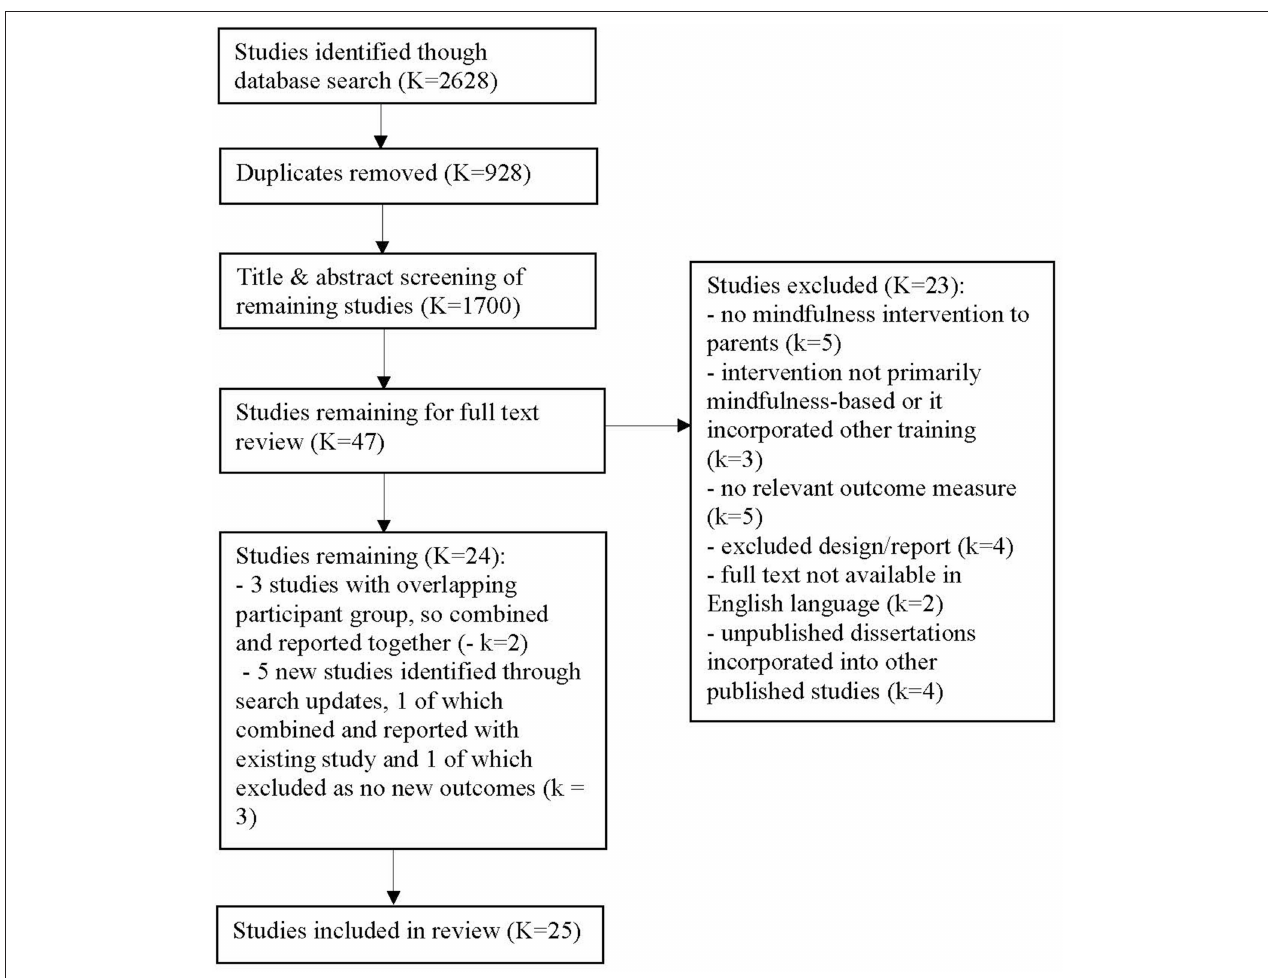
FIGURE 1 | Flow diagram showing process of study